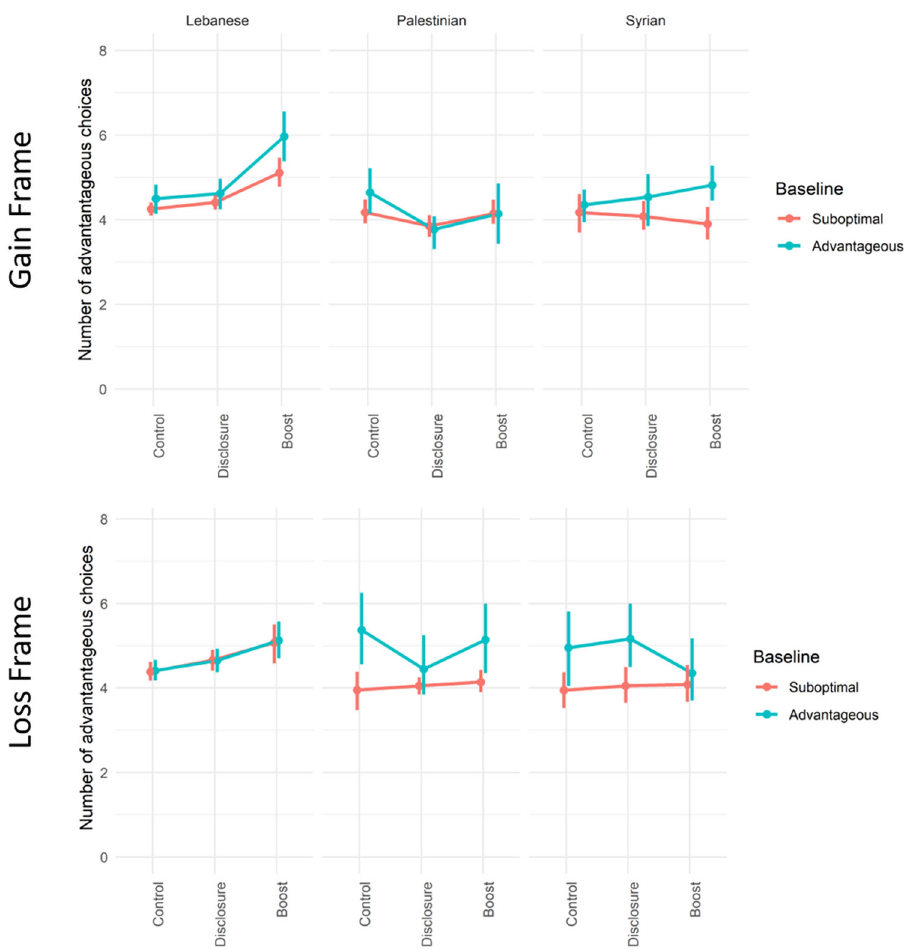
Fig. 8 Advantageous choices by nationality and intervention group. Codes for the baseline choice congruent with the frame of the experimental items. Error bars are 95% bootstrapped CI. Orange indicates those individuals who made a suboptimal choice at baseline; turquoise represents those who made an advantageous choice at